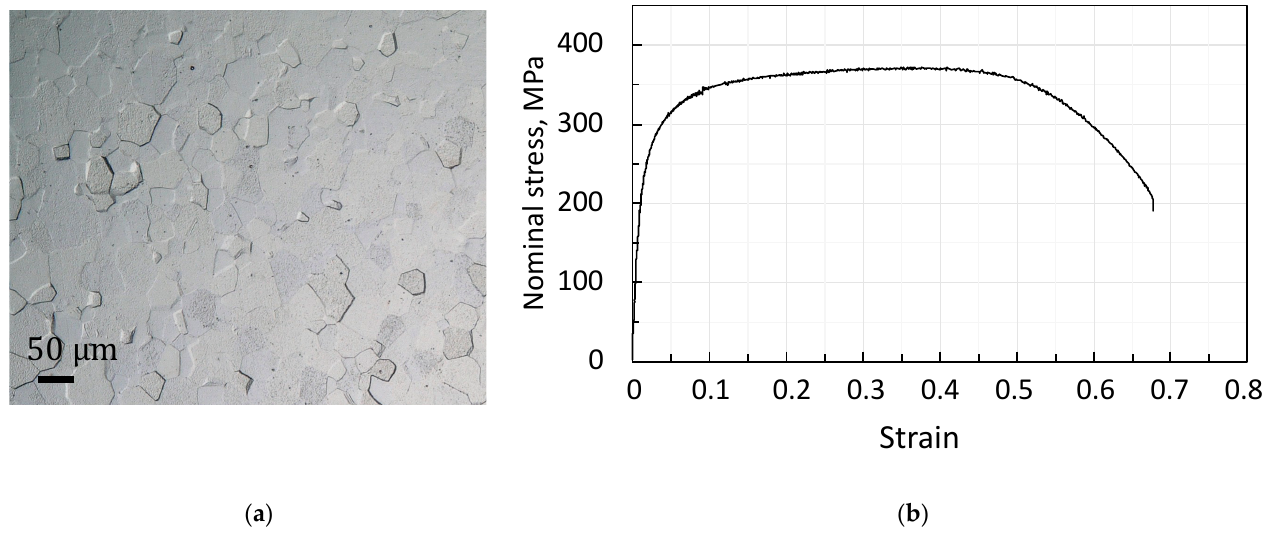
Figure 2. ( a ) Initial microstructure; ( b ) Representative stress–strain curve of the studied CP Ti. Table 2. Summary of fatigue tests results obtained in this study.